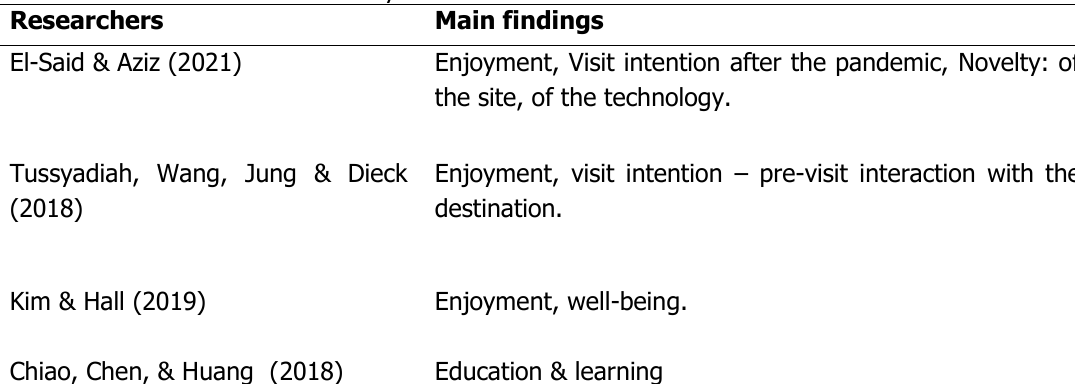
Table 1. Summary of research on virtual tour travel